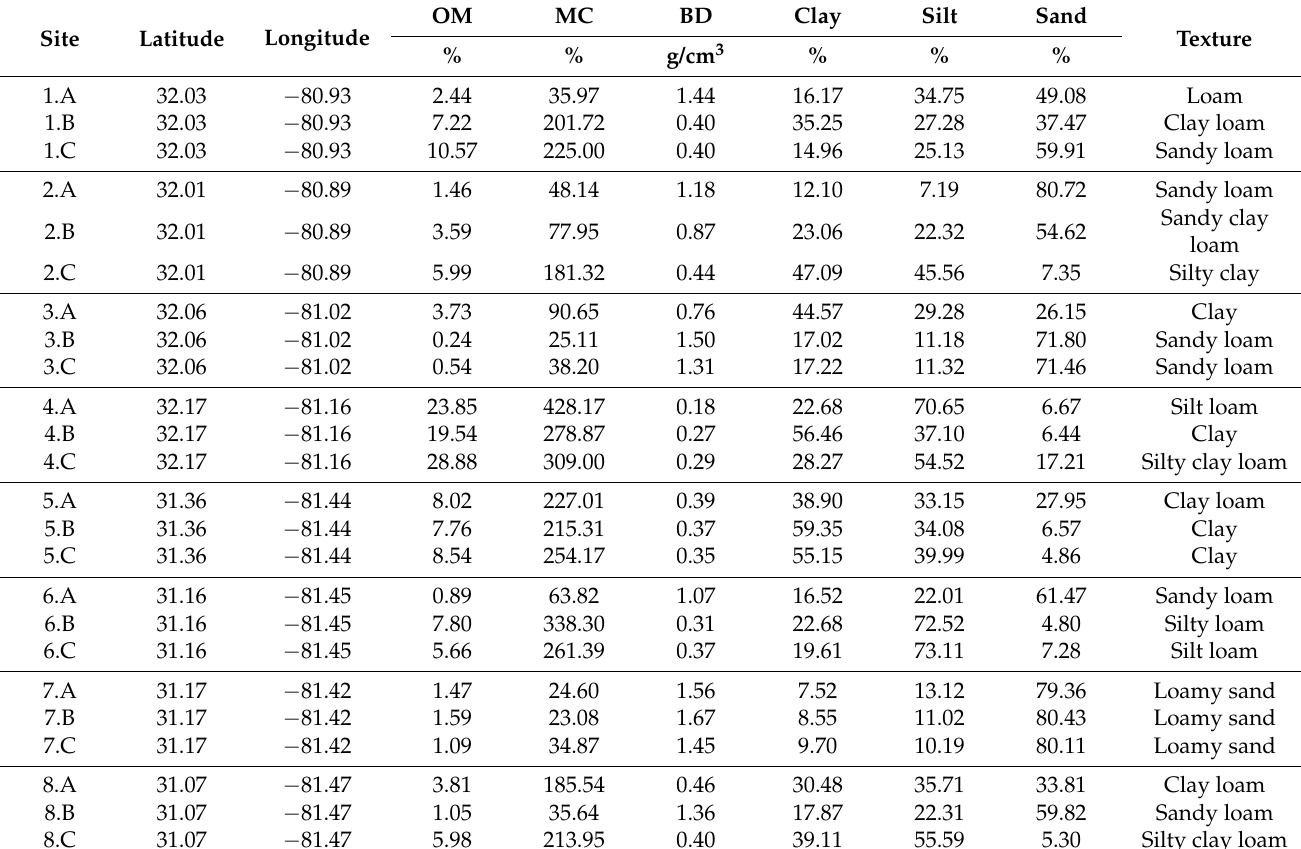
Table 1. Soil properties found at each of 8 sites (in 3 vegetation zones at each site) adjacent to construction projects along the Georgia